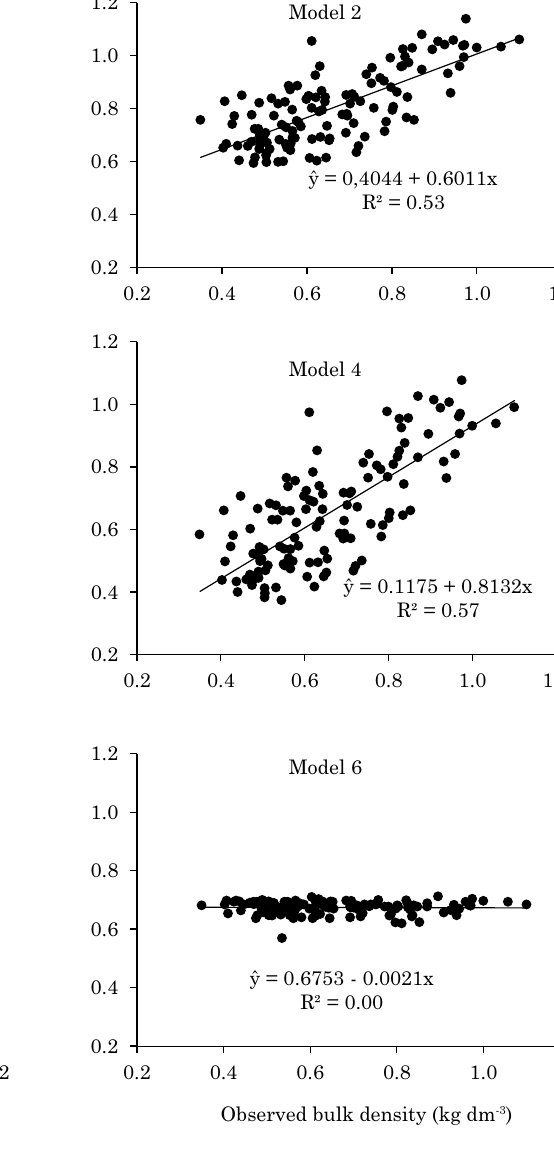
ŷ = 0.1746 + 0.7657x R² =